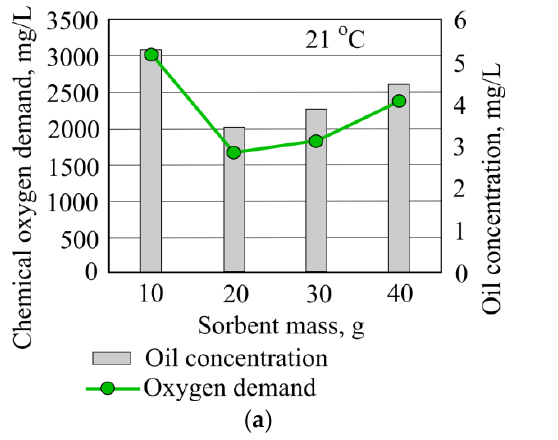
Figure 17. Chemical oxygen demand and oil concentration when investigated water is at ( a ) 21 °C and ( b ) 70 °C using granulated mineral sorbent.